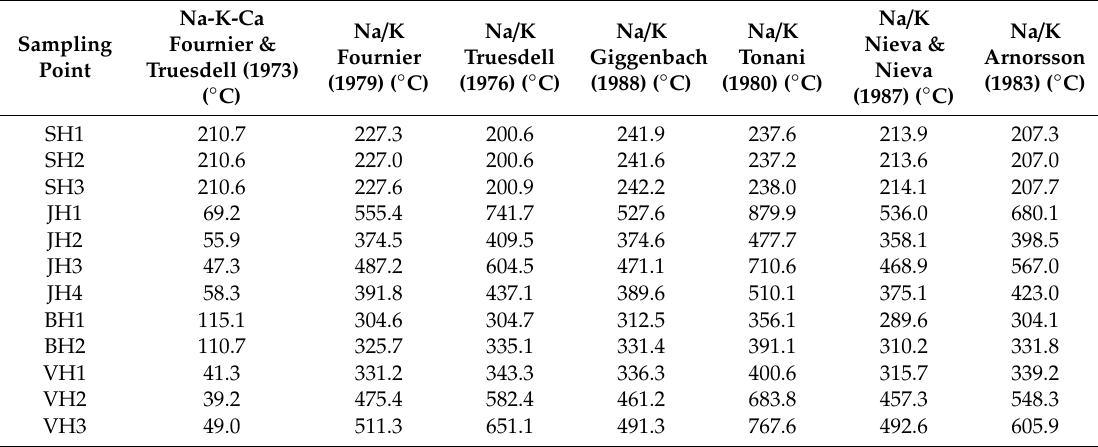
Estimation of reservoir’s temperature of geothermal areas in north zone Seulawah Agam mountain.